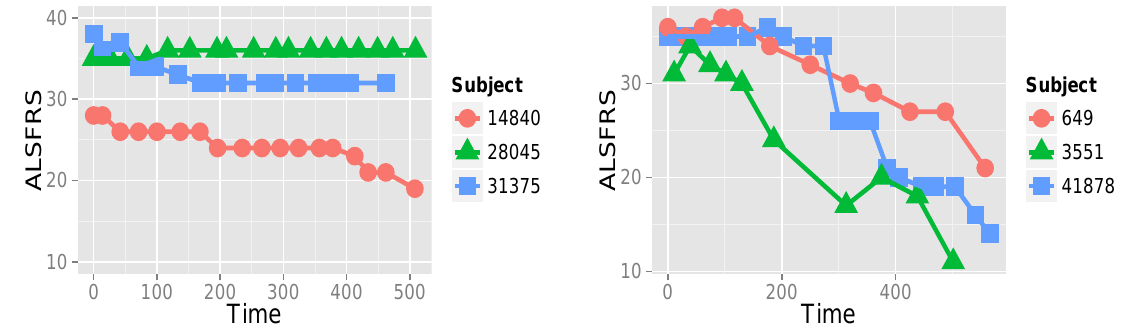
Figure 1. ALSFRS values measuring the patient’s ability in ten functions, such as walking, breathing, and dressing, of six patients from the PRO-ACT database over roughly 500 days. On the left, disease progression of three patients (subjects) is relatively moderate, whereas on the right, deterioration of three other patients is very